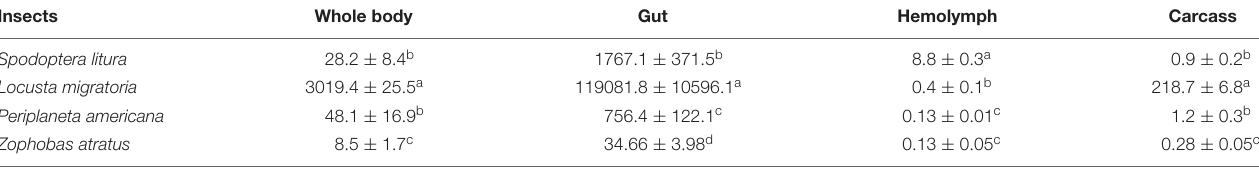
TABLE 1 | Spatial distribution patterns of dsRNA degrading nucleases in four insect species † (RFU · mg − 1 protein · s − 1 ).